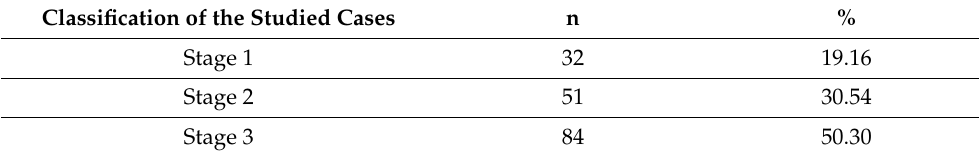
Figure 4. Distribution of new HIV/AIDS cases by CD4+ T-lymphocyte level and HIV viral load. Table 5. Distribution of study cases by CDC, HIV/AIDS classification.